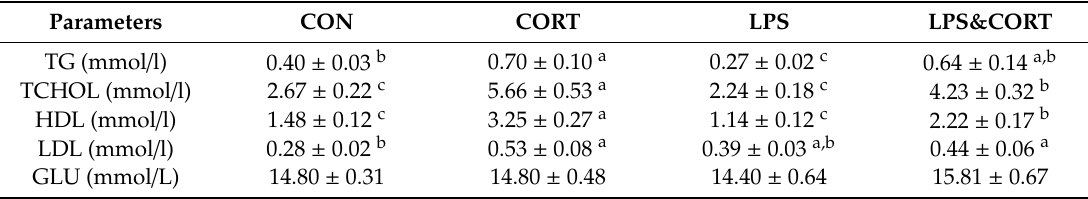
Table 3. E ff ect of CORT and LPS on plasma biochemical parameters.